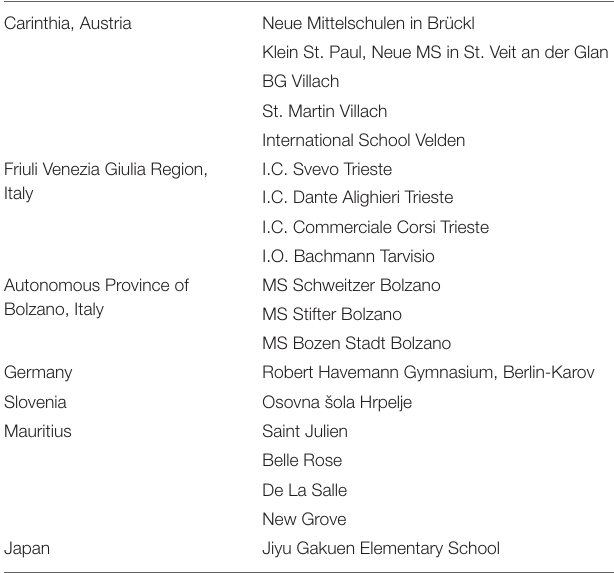
TABLE 1 | Schools that participated in the research